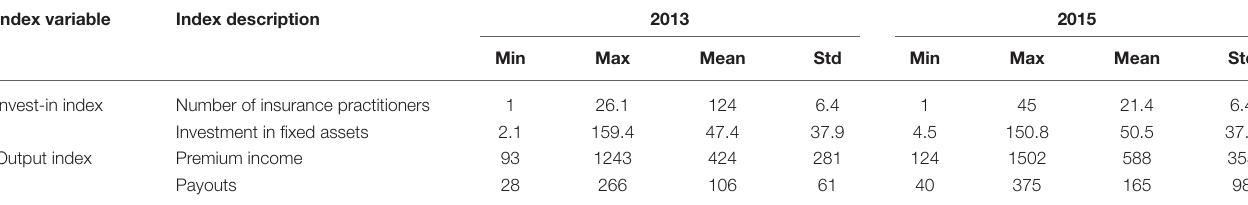
TABLE 2 | Index selection and descriptive